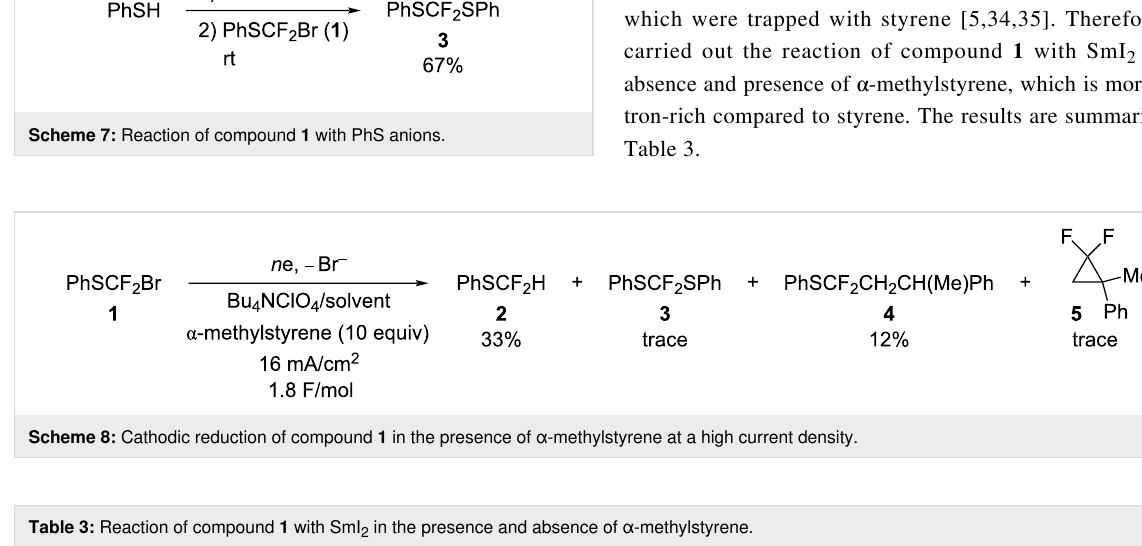
Table 3: Reaction of compound 1 with SmI 2 in the presence and absence of α -methylstyrene.